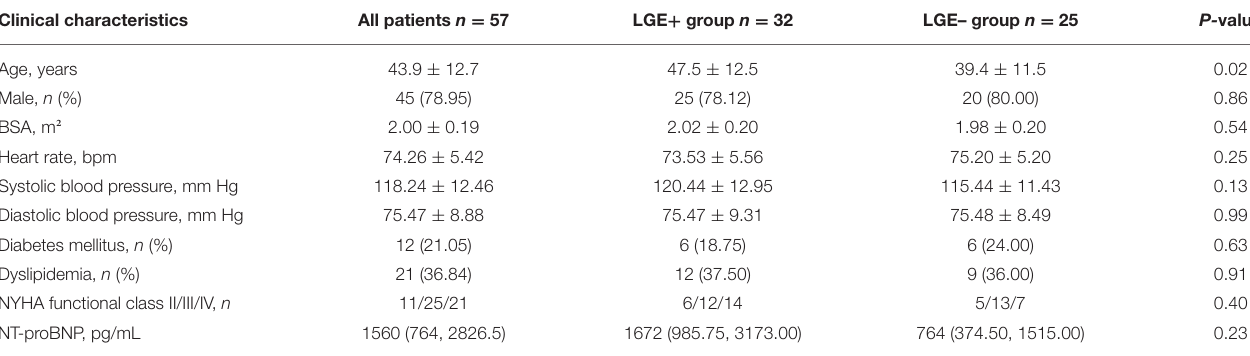
TABLE 1 | Baseline characteristics of the study population and according to presence of LGE.